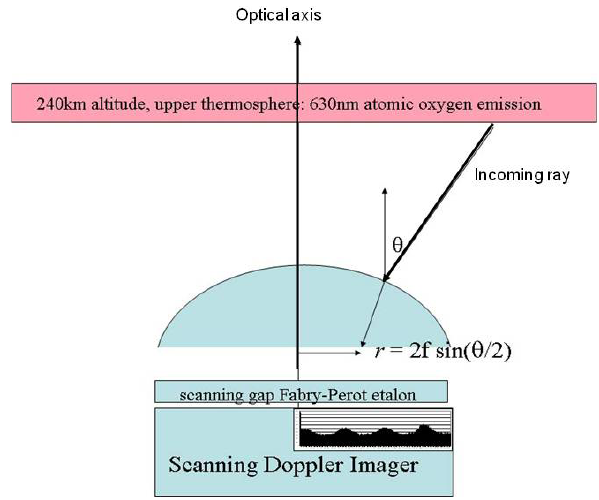
Fig. 2b. The equisolidangle fish-eye lens projection in